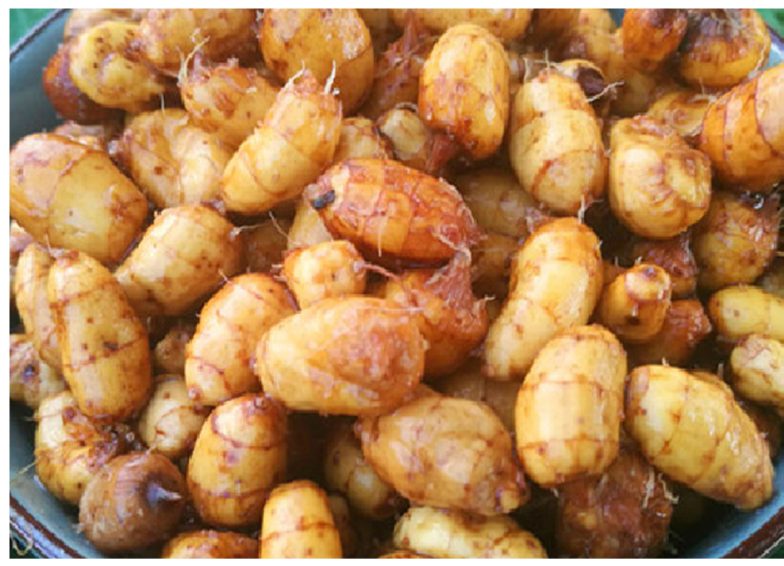
Figure 2. Cyperus ( Cyperus esculentus L.) tubers at maturity.